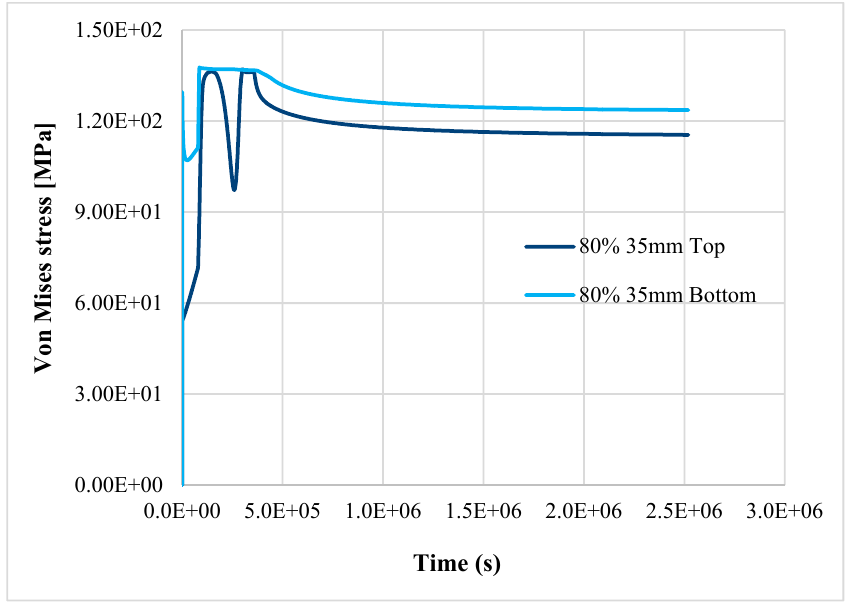
Figure 12. Top and bottom layers of equivalent von Mises stress in thinning—case 3.